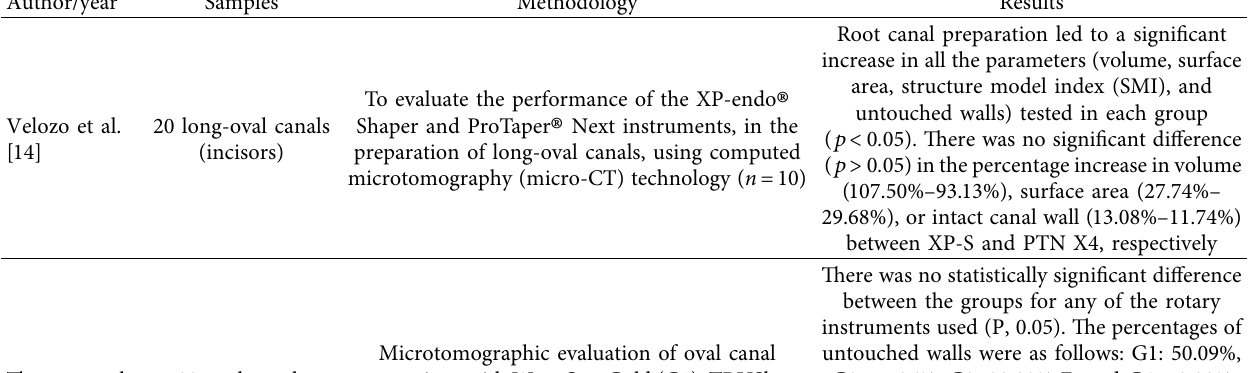
Table 1: Synthesis of articles on the preparation of oval and long-oval root canals, included in the literature review.